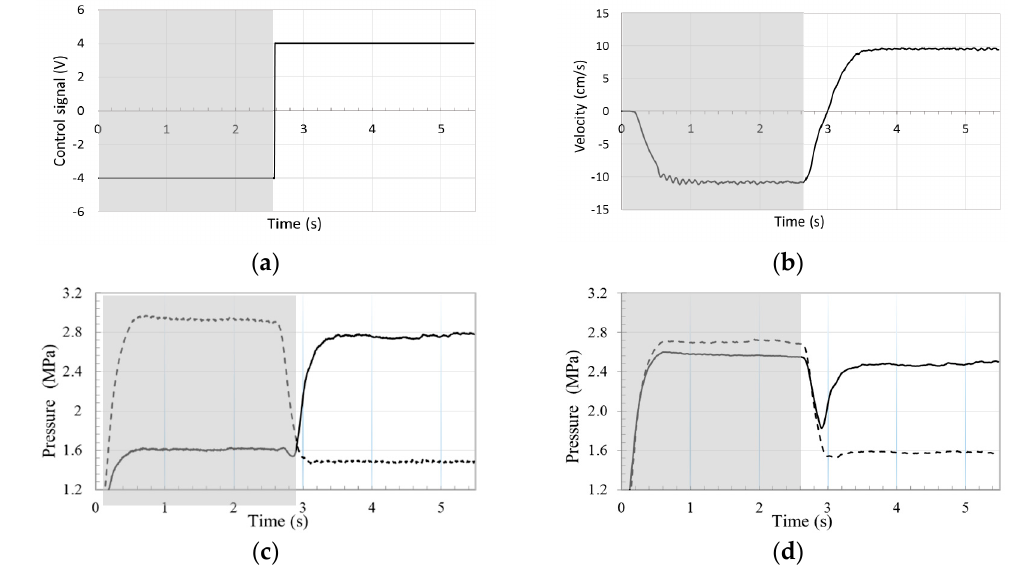
Figure 9. Performance of the proposed circuit in retraction and extension of a 245 kg attached mass: ( a ) control signal; ( b ) actuator velocity; ( c ) pressures at pump ports a (solid line) and b (dashed line); and ( d ) pressures at actuator ports a (solid line) and b (dashed line).